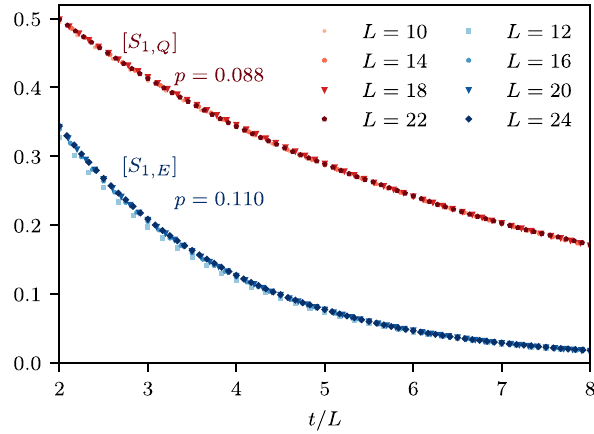
FIG. 4. Dynamicalexponent.Plotoftherescaledtimedependence of the ancilla-circuit entanglement entropy for the entanglement ≈ 0 . 11 (blue curve) and the charge-sharpening transition at p ¼ p c transition at p ¼ p # ≈ 0 . 088 (red curve). The finite size collapse indicates a dynamical exponent z ¼ 1 for both transitions.